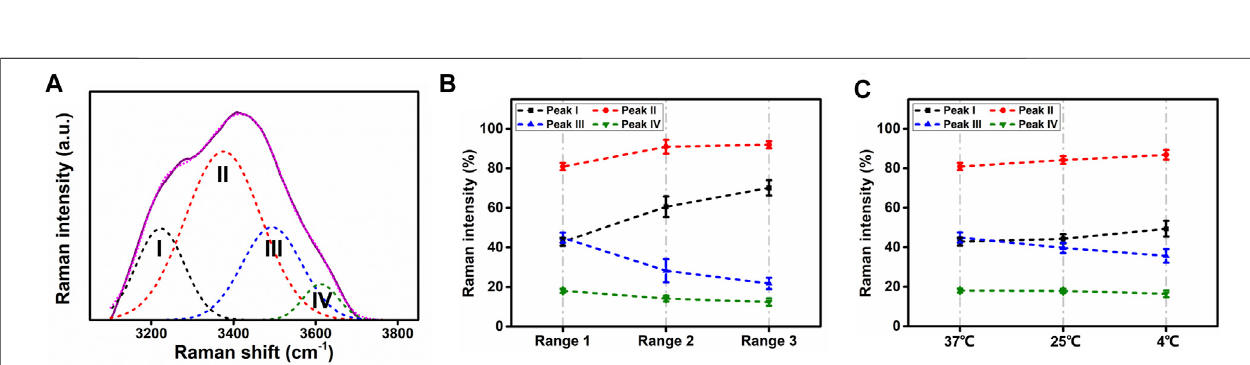
FIGURE5 | Gaussian peaks and intensity changes without opacity. (A) Typical Gaussian fi ttingcomponentsas Gaussian peaks for Raman waterspectra, ranging from 3,100 to 3,800 cm − 1 . I, II, III, and IV stand for Gaussian peaks I, II, III, and IV. (B) Raman intensity of four Gaussian peaks from three regions at 37 ° C. (C) Raman intensity of four Gaussian peaks at 37 ° C, 25 ° C, and 4 ° C in region 1.